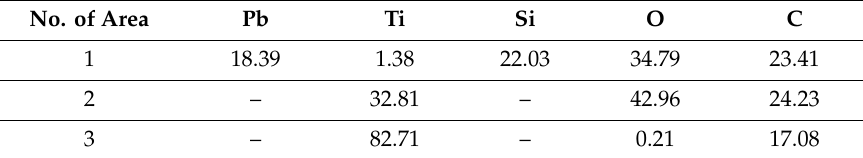
Table 3. Elemental composition of areas 1, 2 and 3 in Figure 6d (at.%).